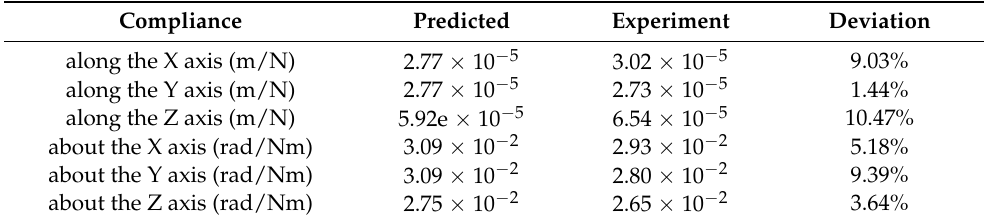
Table 1. Deviations between the experimental compliances compared against the predicted